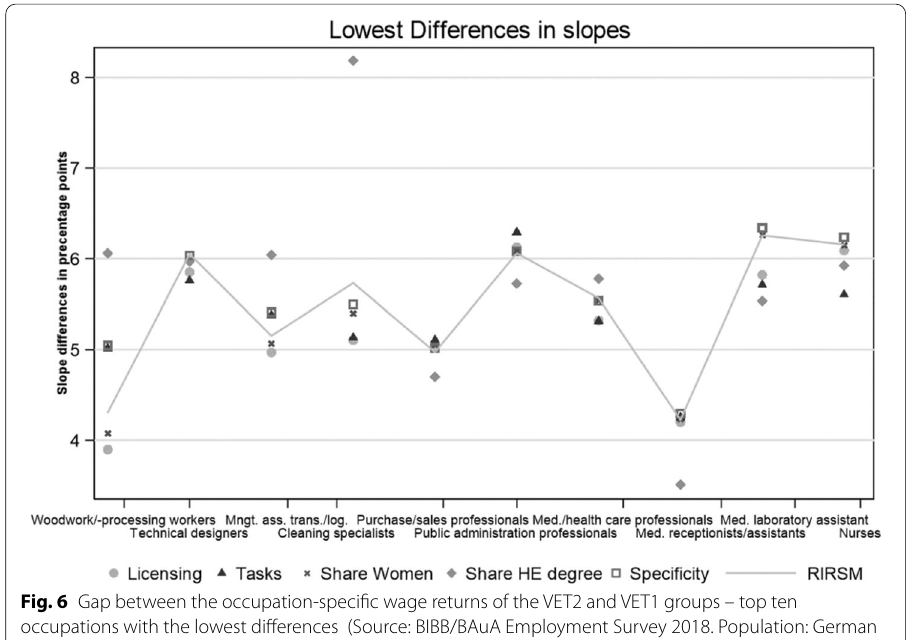
Fig. 6 Gap between the occupation-specific wage returns of the VET2 and VET1 groups – top ten occupations with the lowest differences (Source: BIBB/BAuA Employment Survey 2018. Population: German